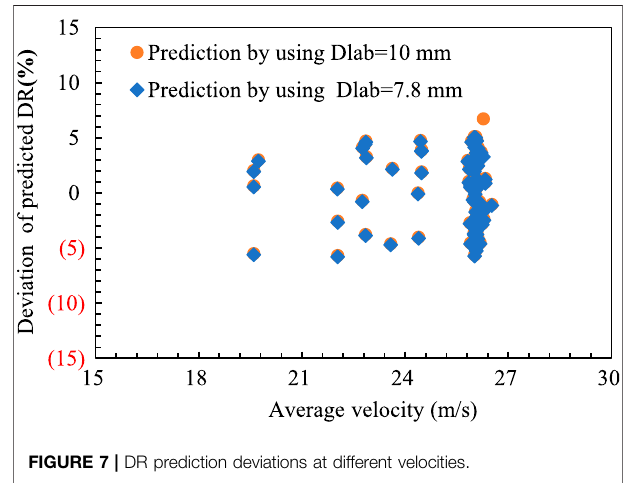
FIGURE 7 | DR prediction deviations at different